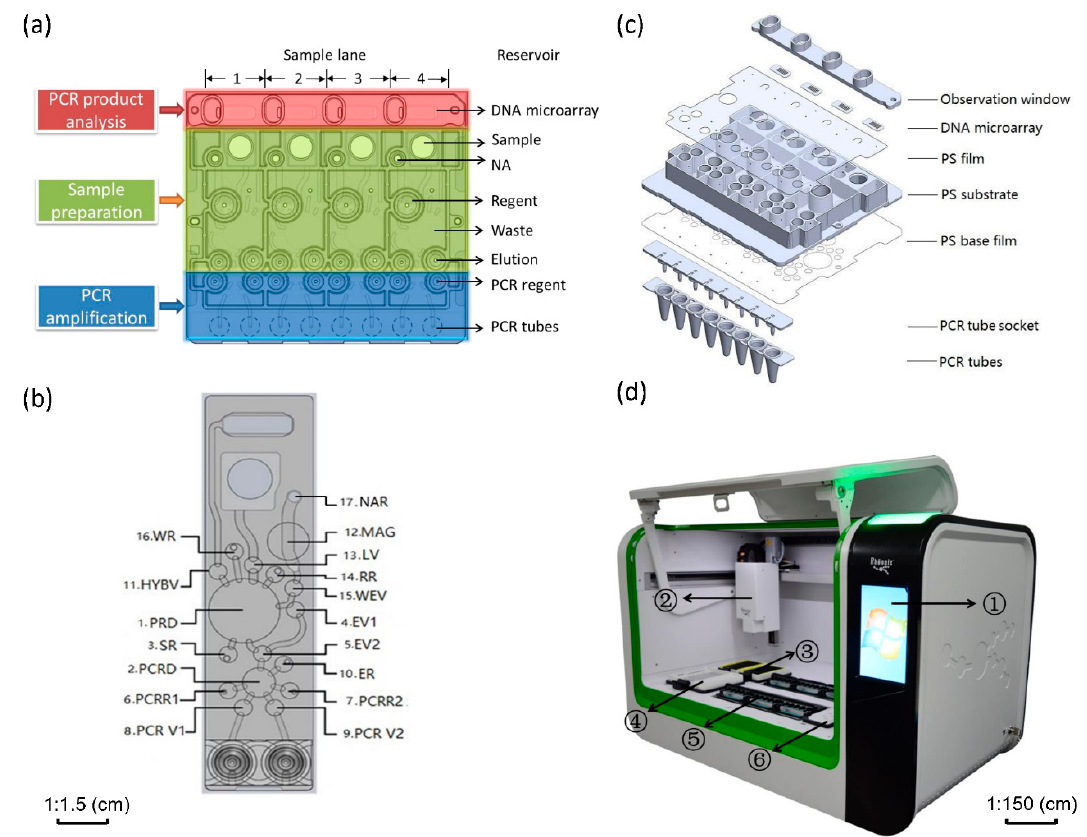
Figure 1. Illustration of the microfluidic system. ( a ) Schematic of CARD. A CARD contains 4 sample lanes, and each sample lane can be divided into 3 functional areas, a sample preparation area (green area), a PCR amplification area (blue area), and a PCR product analysis area (red area). ( b ) The structures contained in a sample lane. 1.PRD (Purification drive), 2.PCRD (PCR drive), 3.SR (Lysis reservoir), 4.EV1 (Elution valve 1), 5.EV2 (Elution valve 2), 6.PCRR1 (PCR reservoir 1),